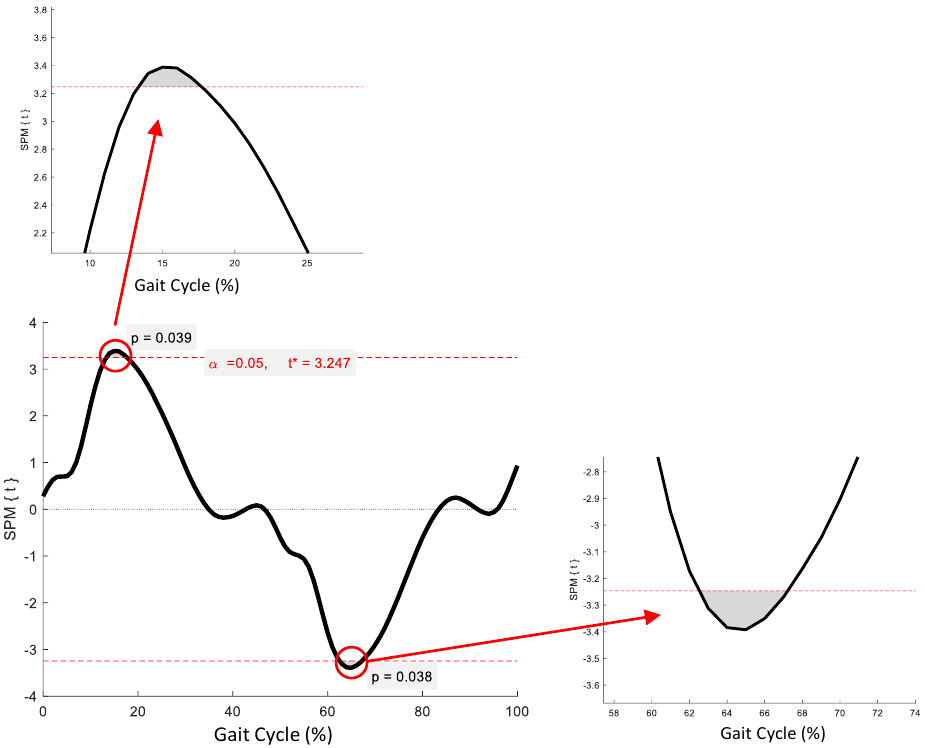
Figure 3. Statistical Parametric Mapping (SPM) output for trunk-P kinematics in the transverse plane. The horizontal red dashed lines represent the critical t * based on α = 0.05 and random field theory calculations of residual smoothness. t * is the critical threshold.